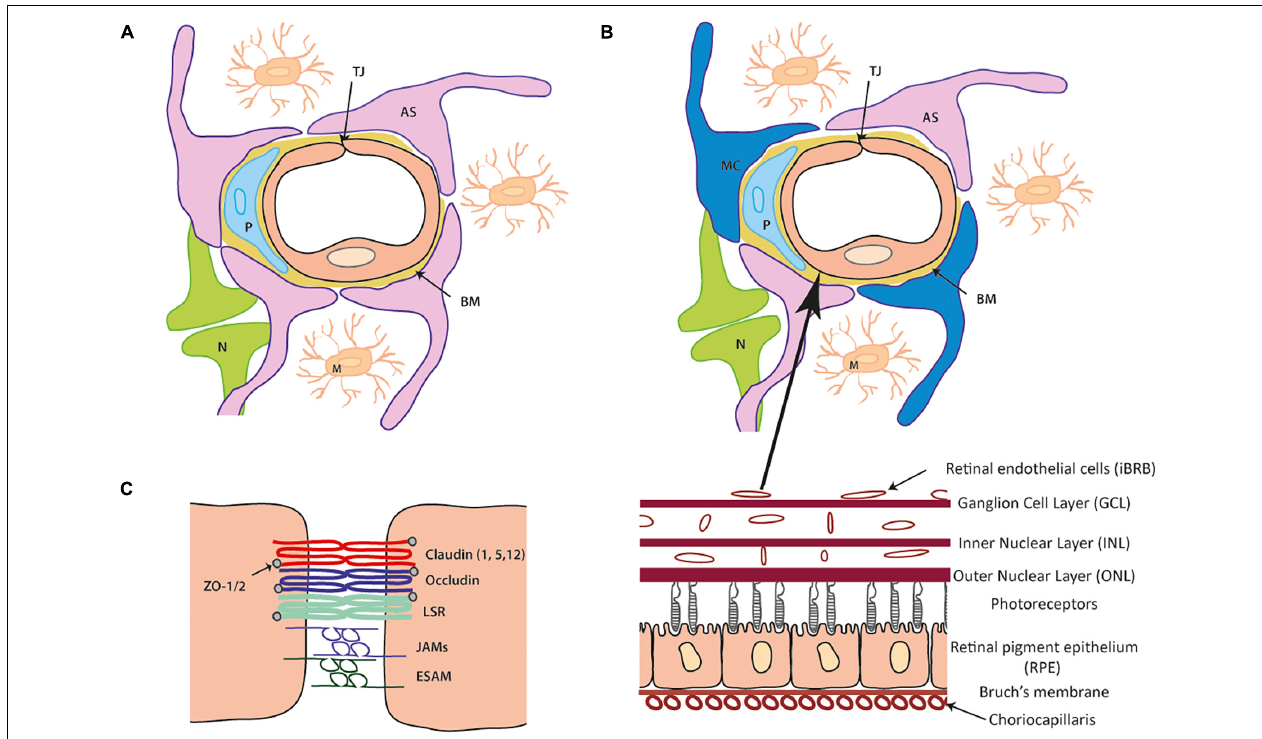
FIGURE 1 | Cellular and tight junction (TJ) protein composition of the blood- brain barrier (BBB) and inner blood-retinal barrier (iBRB). (A) Schematic of the blood brain barrier (BBB) neurovascular unit (NVU). A single endothelial cell (EC) forms the lumen of the blood vessels surrounded by a pericyte (P) and the basement membrane (BM) containing laminins, nidogens, collagen IV and heparin sulfate proteoglycans. Astrocytes (AS) end-feet ensheath the cell complex with neurone (N) and microglia (M) present in the microenvironment. (B) The iBRB is similar in composition to the BBB (as seen in A ) although pericytes (P) are at a ratio of 1:1 with endothelial cells (EC) and Muller cell (MC) processes wrap around the blood vessels along with the astrocytes (AS). The iBRB is found in the retina from the ganglion cell layer (GCL) to the outer nuclear layer (ONL). (C) Schematic of tight junction proteins expressed that join the same endothelial cell or adjacent endothelial cells to one another. Claudin-5 is expressed most abundantly with contribution from claudin 1 and 12 (other family members shown to be expressed in other NVU cells). The TAMPs (occludin, tricelllin) and LSR along with JAM family members ( A–C and ESAM) constitute the additional transmembrane proteins. Zonula occludens (ZO) 1 and 2 are expressed cytoplasmic which can form a structural link to the actin cytoskeleton and associate with actin binding